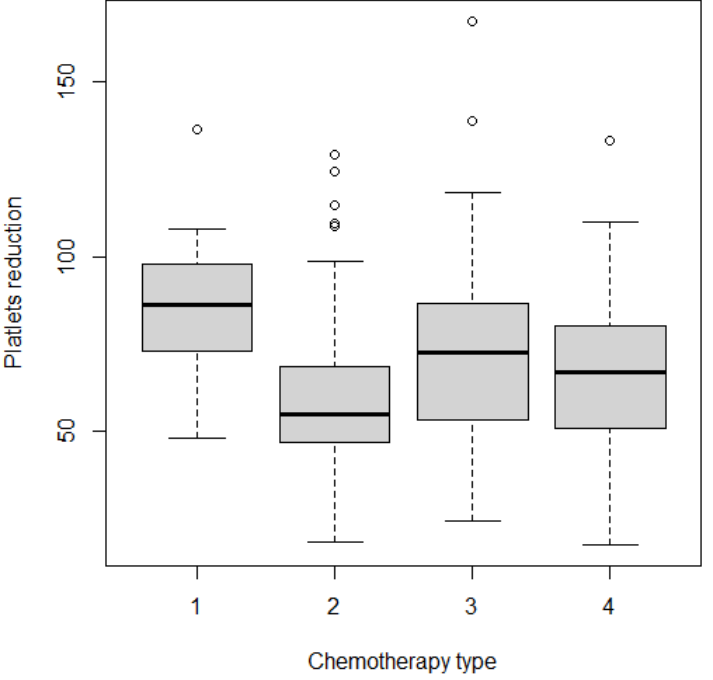
Figure 3. Comparison of platelet reduction grouped by type of chemotherapy administered. 1 = 1- drug regime, 2 = 2-drug regime, 3 = 3-drug regime, 4 = trastuzumab-based regime. ° = outliers. Table 2. Cox regression analysis for baseline platelet and platelets reduction.